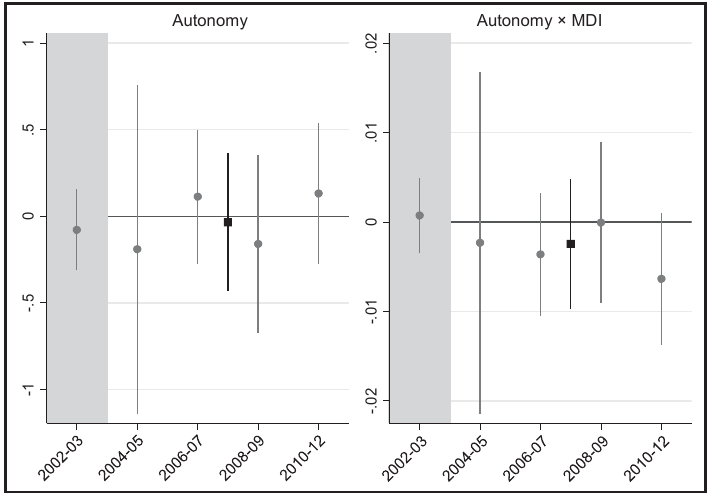
The effect of municipal autonomy on number of test takers (% change). Notes: The figure plots the coefficients on municipal autonomy (left) and on the interaction between autonomy and development (right), estimated at different postreform periods. Black squares indicate over-time average estimates, and spikes represent 95% confidence